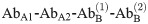
Neutralization of multidomain antibodies.(A,B) The potency of the 2-Ab constructs and their constitutive antibodies against a panel of influenza strains. AbA1 primarily binds influenza A group 1 (blue), AbA2 to influenza A group 2 (green), and the two AbB antibodies to influenza B strains (gold). (C) All four antibodies were tethered to form the linear chain AbA1-AbA2-AbB(1)-AbB(2) and (D) two copies of this chain were placed on an IgG backbone. The model suggests that the two arms of the IgG are not capable of simultaneously binding a virion. Red lines indicate two outlier influenza strains discussed in the text that are not neutralized by AbA1 or AbA2 individually but are highly neutralized by their combination. Data was digitized from Figs 1 and 3 of Ref [7].